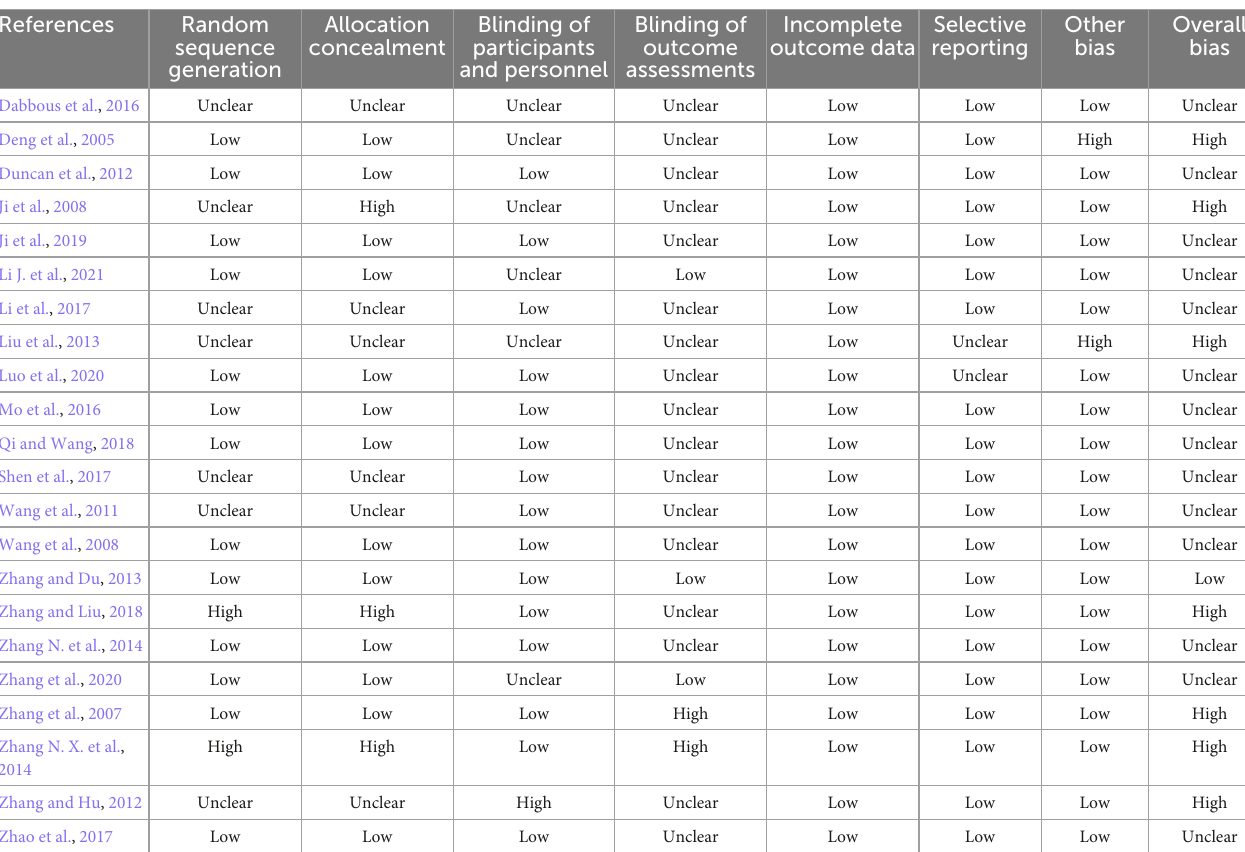
TABLE 3 The Cochrane collaboration’s tool of assessing risk of bias for methodological